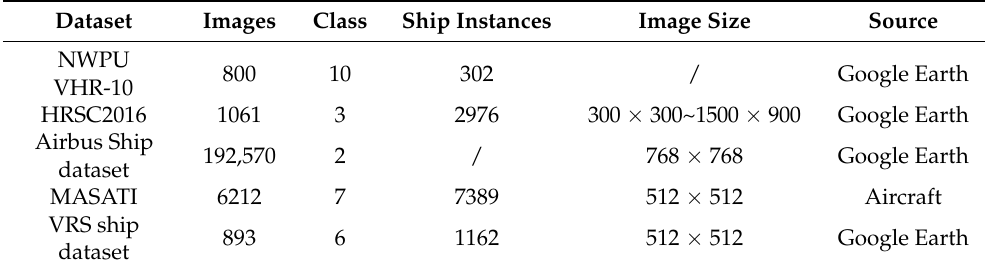
Table 1. Comparison of different optical remote sensing datasets.